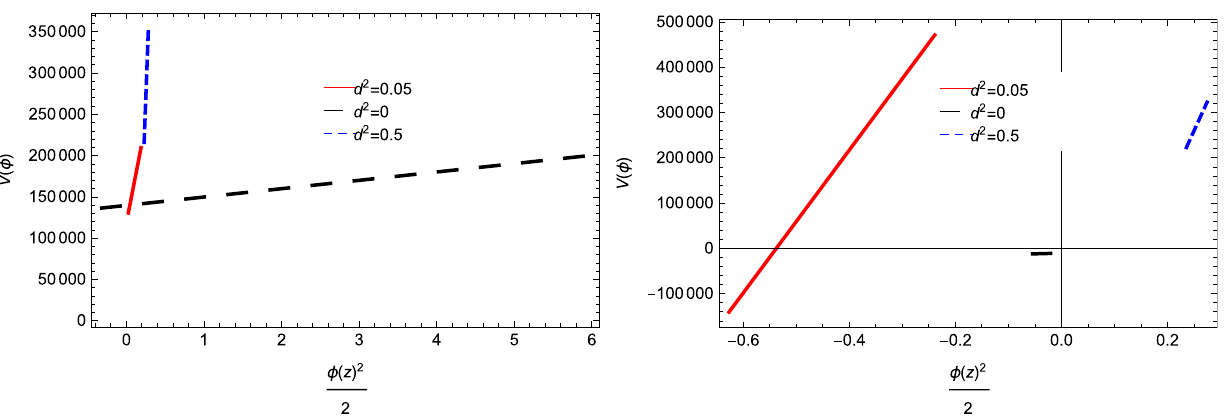
Fig. 41 Plot of V verses z for u = 1 and u = 2 . 002 for K-essence scalar field model